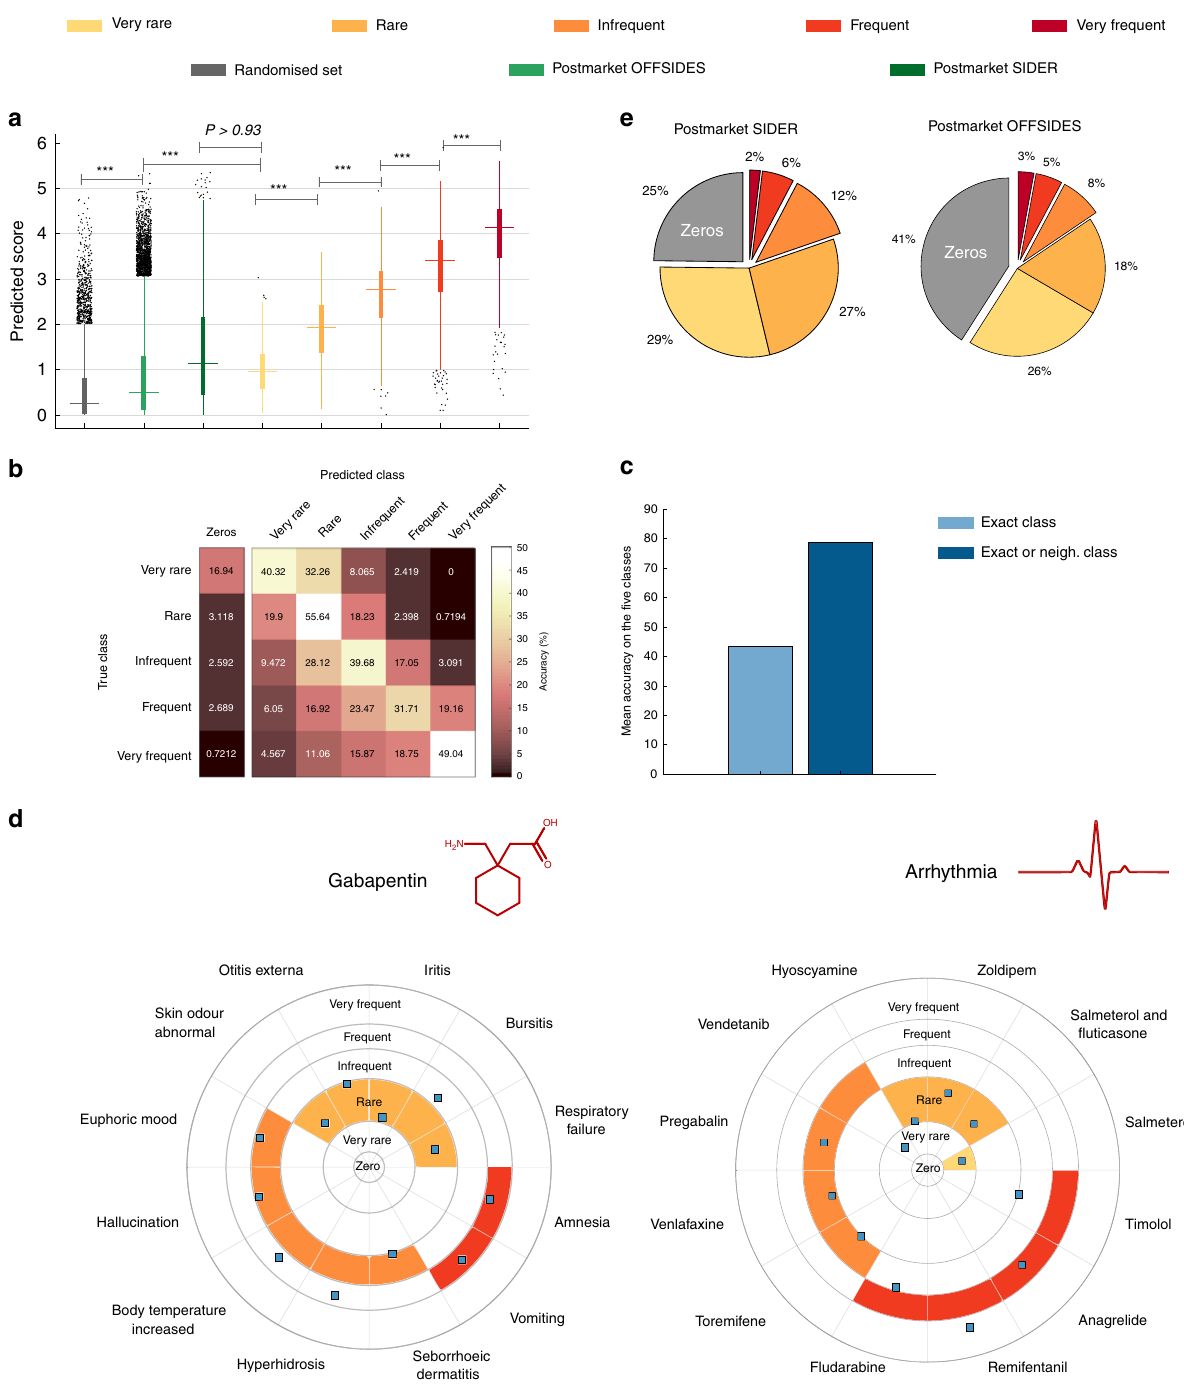
Fig. 3 Evaluation of our method on multiple drugs. a Box plots of the predicted scores obtained for the three test sets: (1) predicted scores for each of the fi ve frequency classes in the held-out test set (in yellow to red scale). The differences in the distributions are statistically signi fi cant: rare vs very rare ( P < 2.80 × 10 − 12 ), infrequent vs rare ( P < 1.31 × 10 − 40 ), frequent vs infrequent ( P < 3.45 × 10 − 51 ) and very frequent vs frequent ( P < 9.00 × 10 − 26 ); (2) SIDER and OFFSIDES post-marketing (in green scale); (3) randomised post-marketing set (in grey). The differences in the distributions between the randomised set and the other sets are statistically signi fi cant (largest P < 1.80 × 10 − 20 ). Signi fi cance levels between the scores are indicated with asterisks (*** P ≤ 0.001). One-tailed Wilcoxon rank-sum test was used in all the cases. b Accuracy percentages for the predictions in the held-out test set. c Mean accuracy on the exact class together with the mean accuracy at predicting the exact class or one of the neighbouring classes. d Illustrative examples from the held- out test set. Twelve randomly chosen predictions for the anticonvulsant drug Gabapentin (left) and the cardiovascular side effect arrhythmia (right) are shown around polar plots, each in a dedicated sector. Grey concentric circles between frequency classes correspond to thresholds learned by maximum likelihood. The correct class for each association is coloured in each circular sector, while predicted scores are shown as blue squares. e Pie chart of predicted frequency classes assigned to the SIDER and OFFSIDES post-marketing test